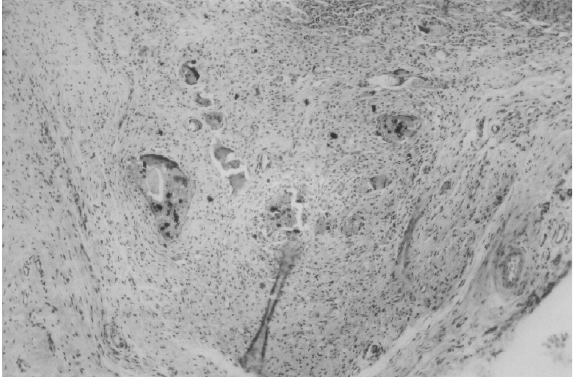
FIGURA 8- Apexit – 45 dias: tecido de granulação persistente. Atividade macrofágica sobre o material extravasado. HE Nikon 80x